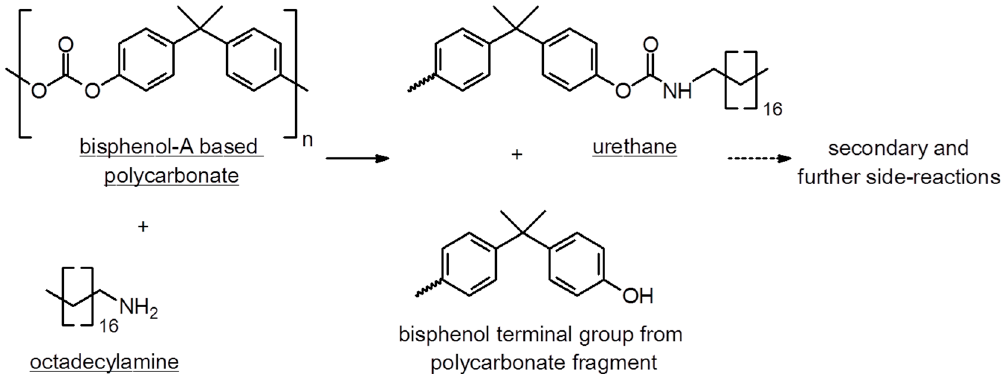
Figure 6. First step of chemical reaction between polycarbonate and octadecylamine, which shows the initial formation of urethane and the remaining chain fragment of polycarbonate. Secondary reactions are described elsewhere [48].